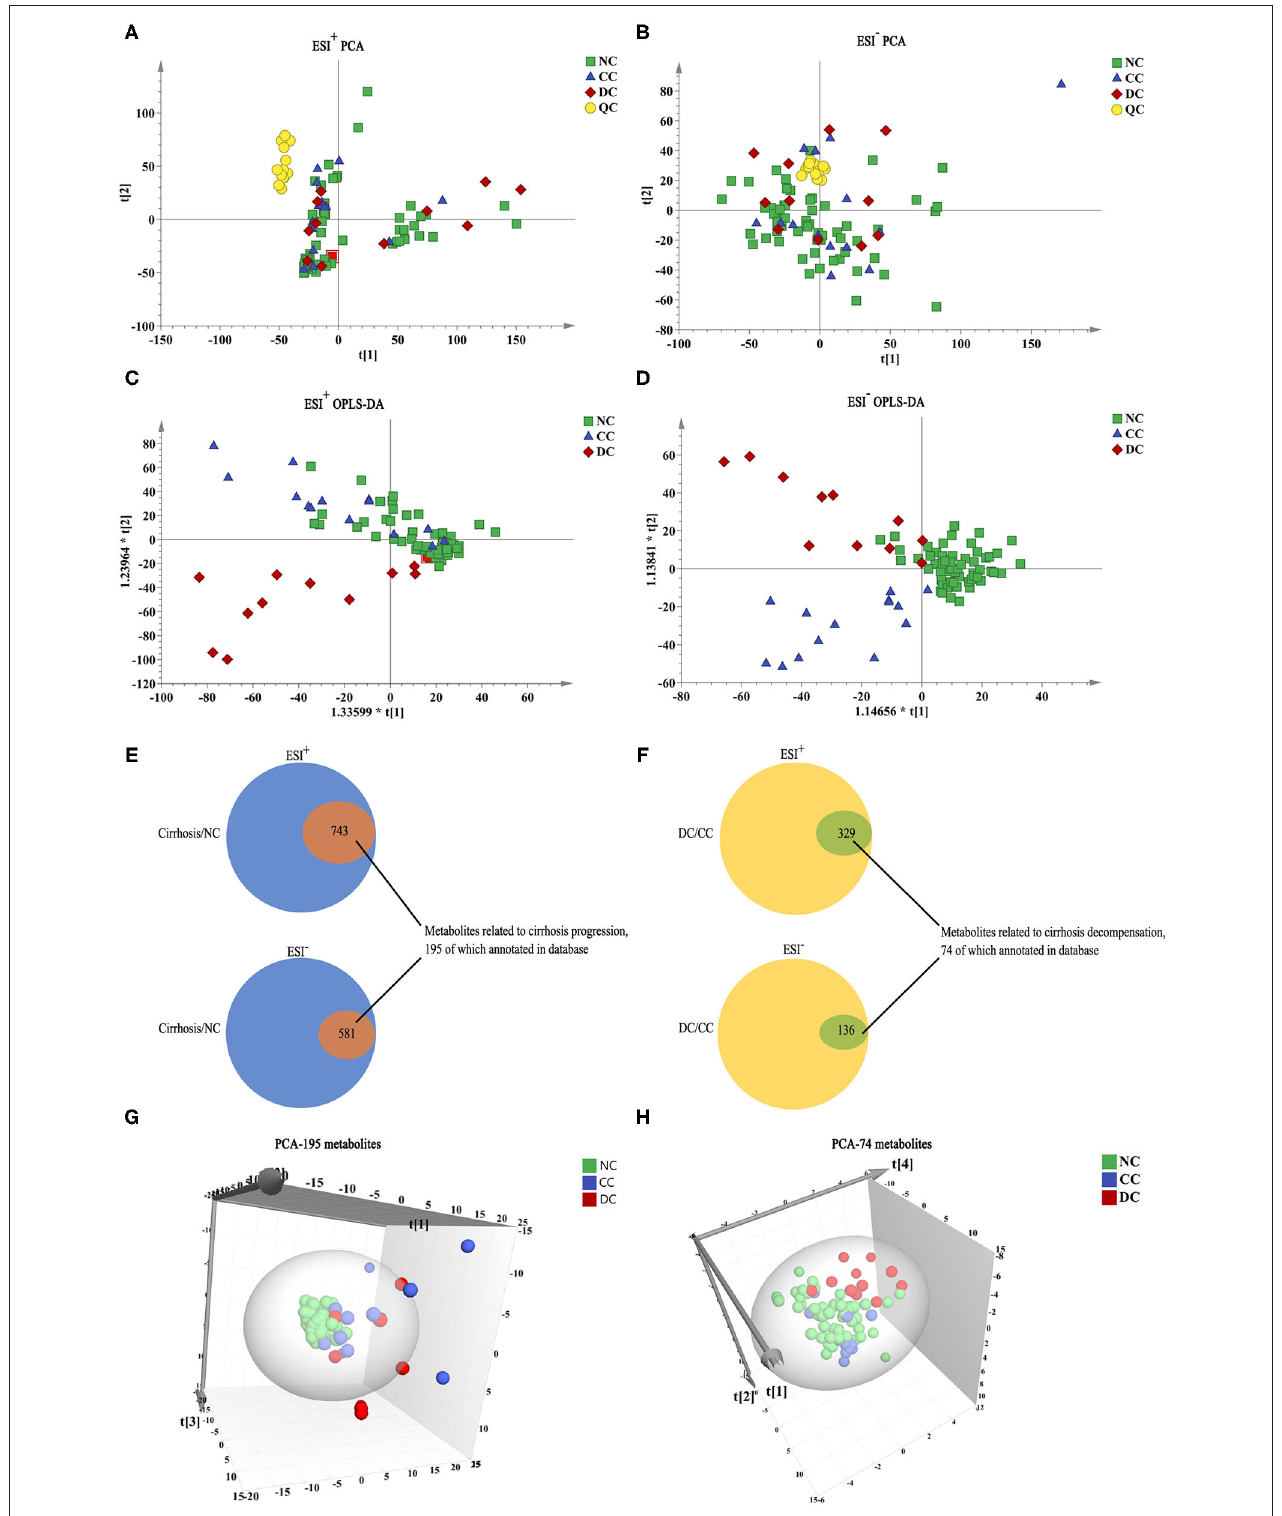
FIGURE 1 | Metabolome profile for chronic DILI with or without cirrhosis. (A–D) PCA, and OPLS-DA model analysis of all variables among NC group ( n = 58, green square), CC group ( n = 14, blue triangle), DC group ( n = 11, red diamond), and QC ( n = 14, yellow circle). (E,F) Venn diagram, the inner section of diagram has a set of variables associated with cirrhosis and decompensation, 195 and 74 metabolites annotated for metabolome feature cirrhosis and decompensation, respectively. (G,H) PCA 3-dimensional scatter plot of cirrhosis (CC + DC) vs. NC with 195 cirrhosis-related metabolites and DC vs. CC with 74 decompensated-related metabolites.